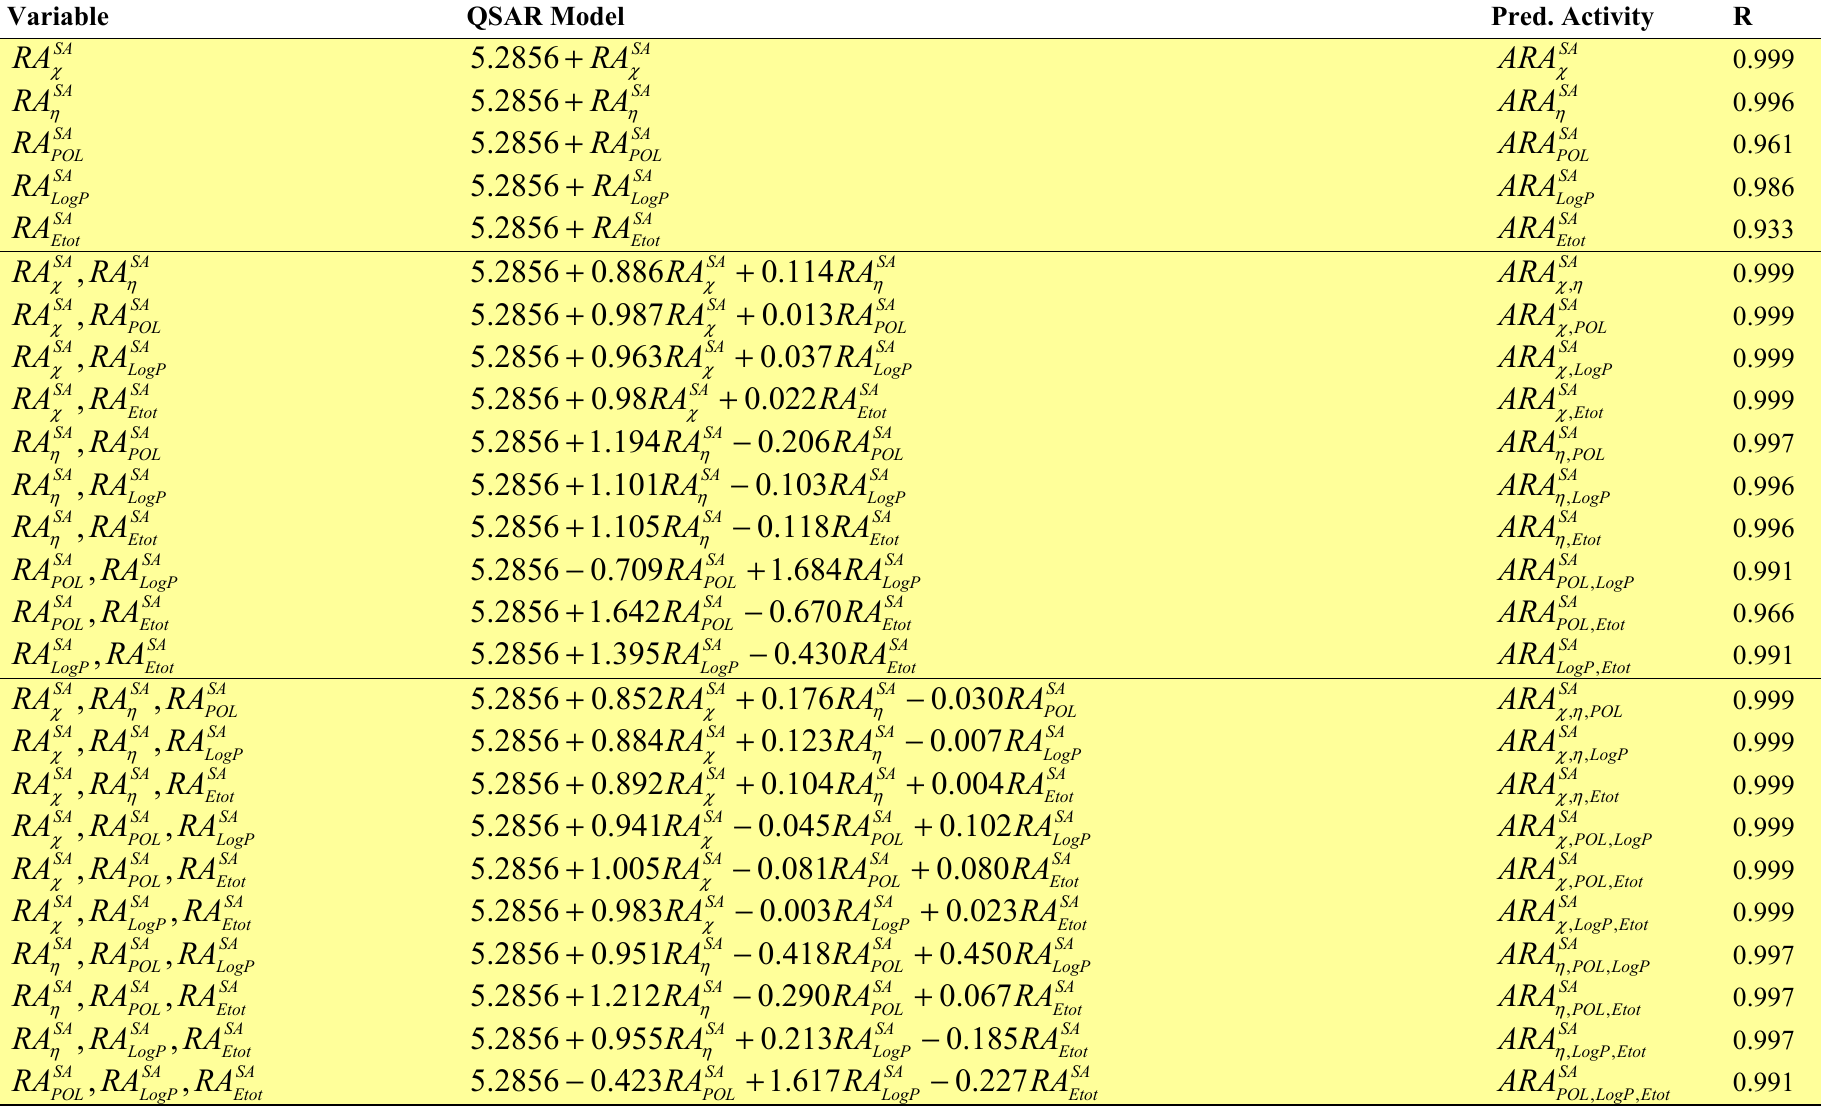
Table 5. Residual-QSARs for the structural alert models of Table